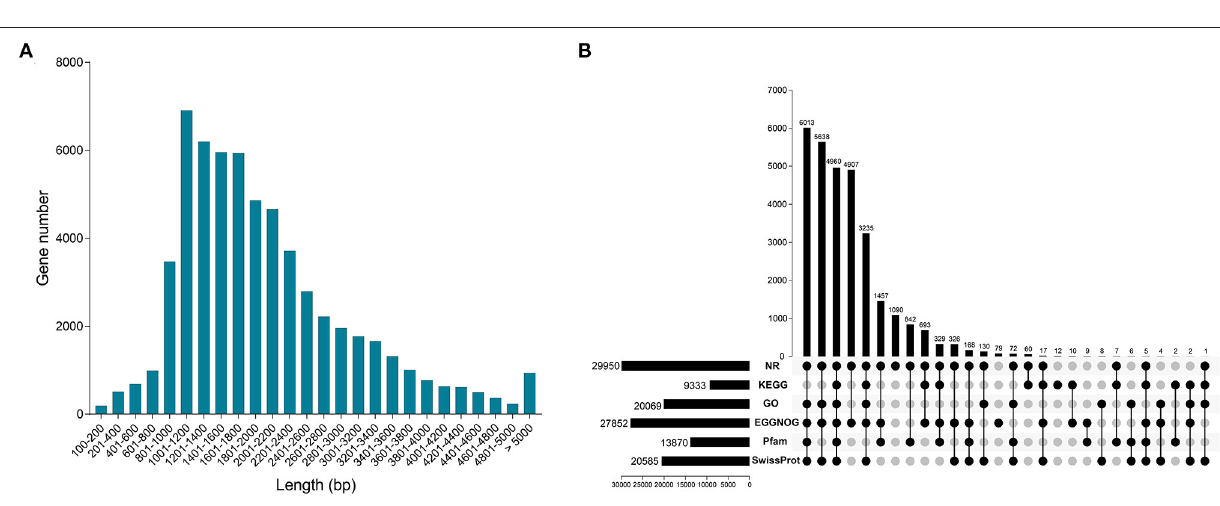
used to show the expression patterns of genes and reflect the expression trend of genes in different samples ( 36,